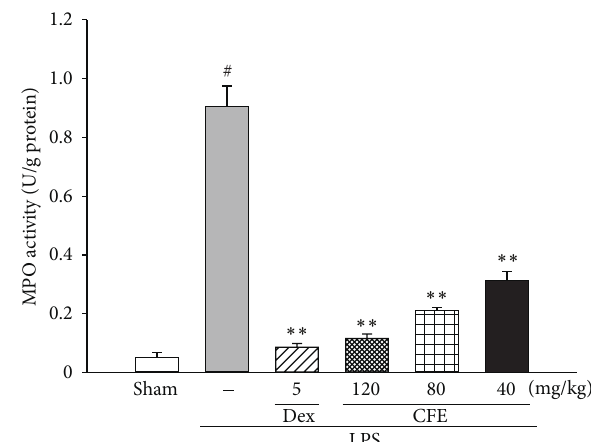
Figure 4: The effects of CFE on MPO activity. Data was represented asthemean ± SEM( 𝑛 = 10 ). # 𝑃 < 0.01 comparedtotheshamgroup; ∗ 𝑃 < 0.05 and ∗∗ 𝑃 < 0.01 compared to the LPS group.